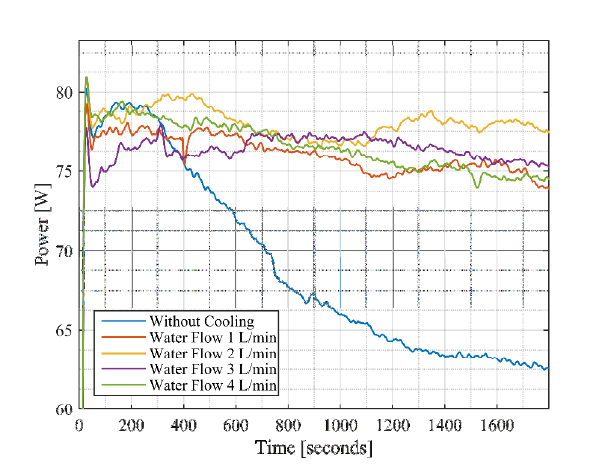
Fig. 4. Effect of water flow rate in the generation of the maximum power.